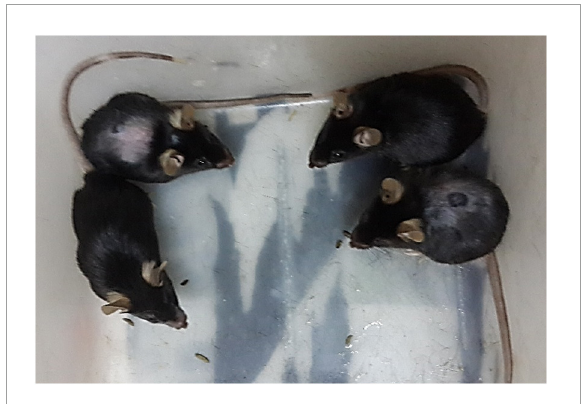
FIGURE1 Mouse strains. VDR + / − C57BL/6J mice (upper left and lower right) and VDR + / + C57BL/6J mice (lower left and upper